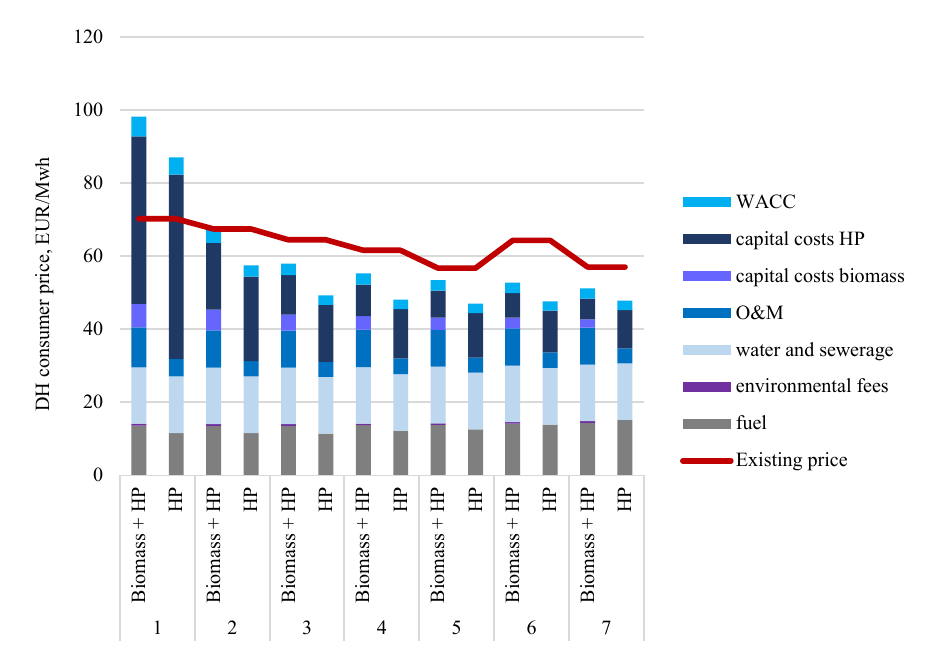
Fig. 6. DH consumer price divided by costs for both solutions and existing consumer price.